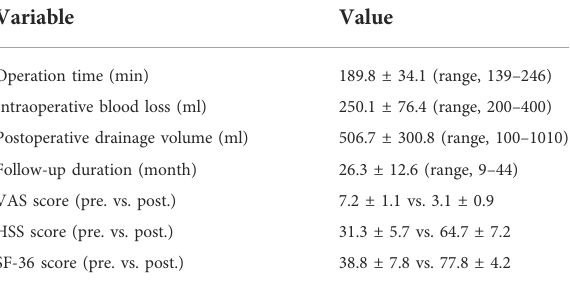
TABLE 2 Relevant data of operation and